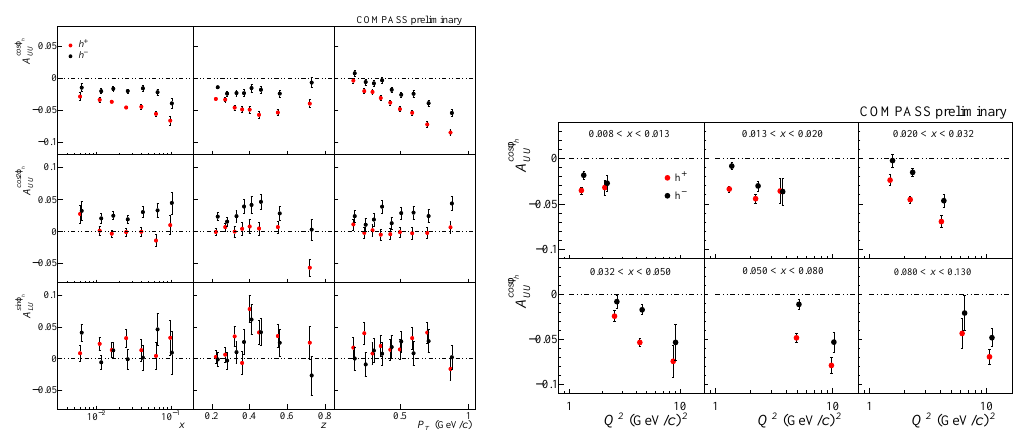
φ φ h h (top row), A cos2 (middle row) and UU UU φ h in bins of x for positive (red) and UU